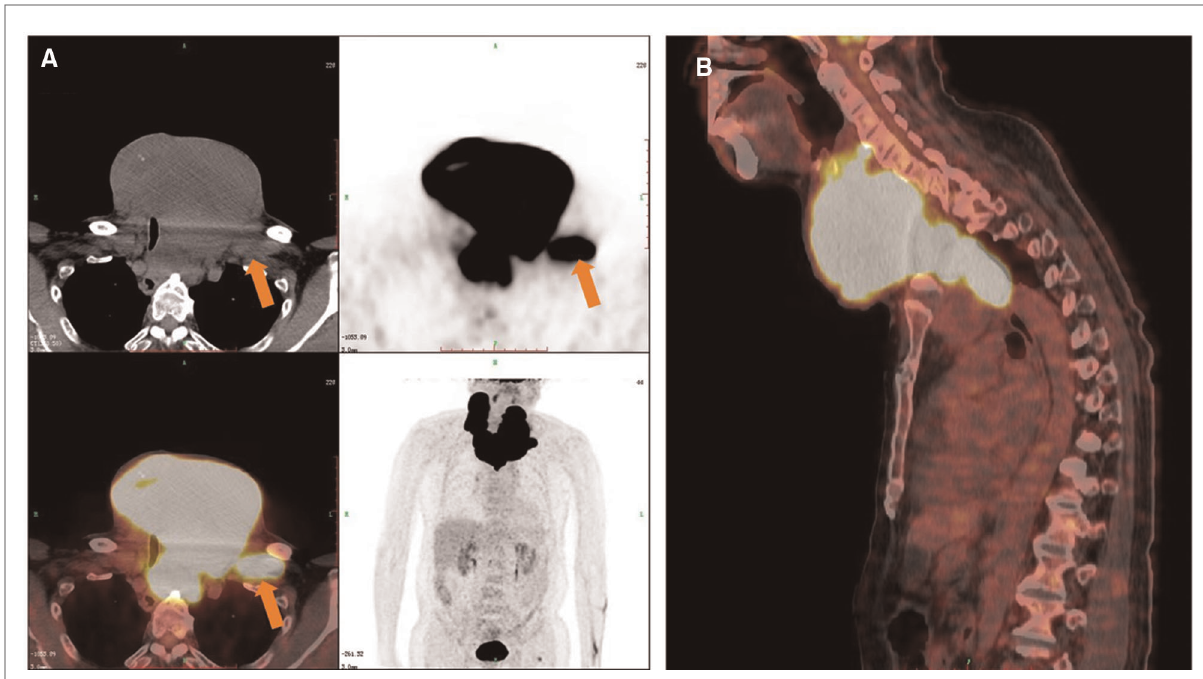
FIGURE 3 PET/CT images of the patient. Increased 18F-FDG metabolism showed in the thyroid and cervical lymph nodes on the ( A ) transverse, coronal and ( B ) sagittal sections. The orange arrow indicated one of the cervical metastatic lymph